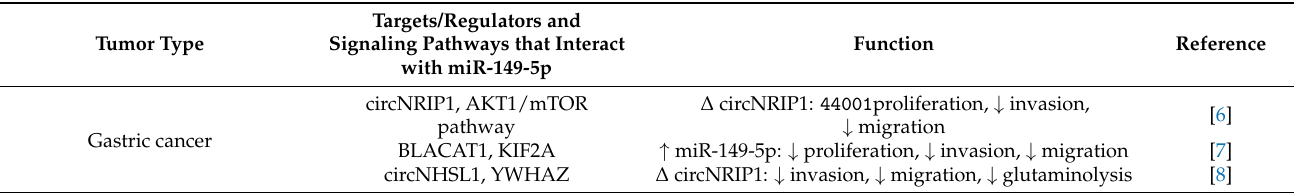
Table 1. Role of miR-149-5p or miR-149-5p-interacting genes in carcinogenesis based on cell